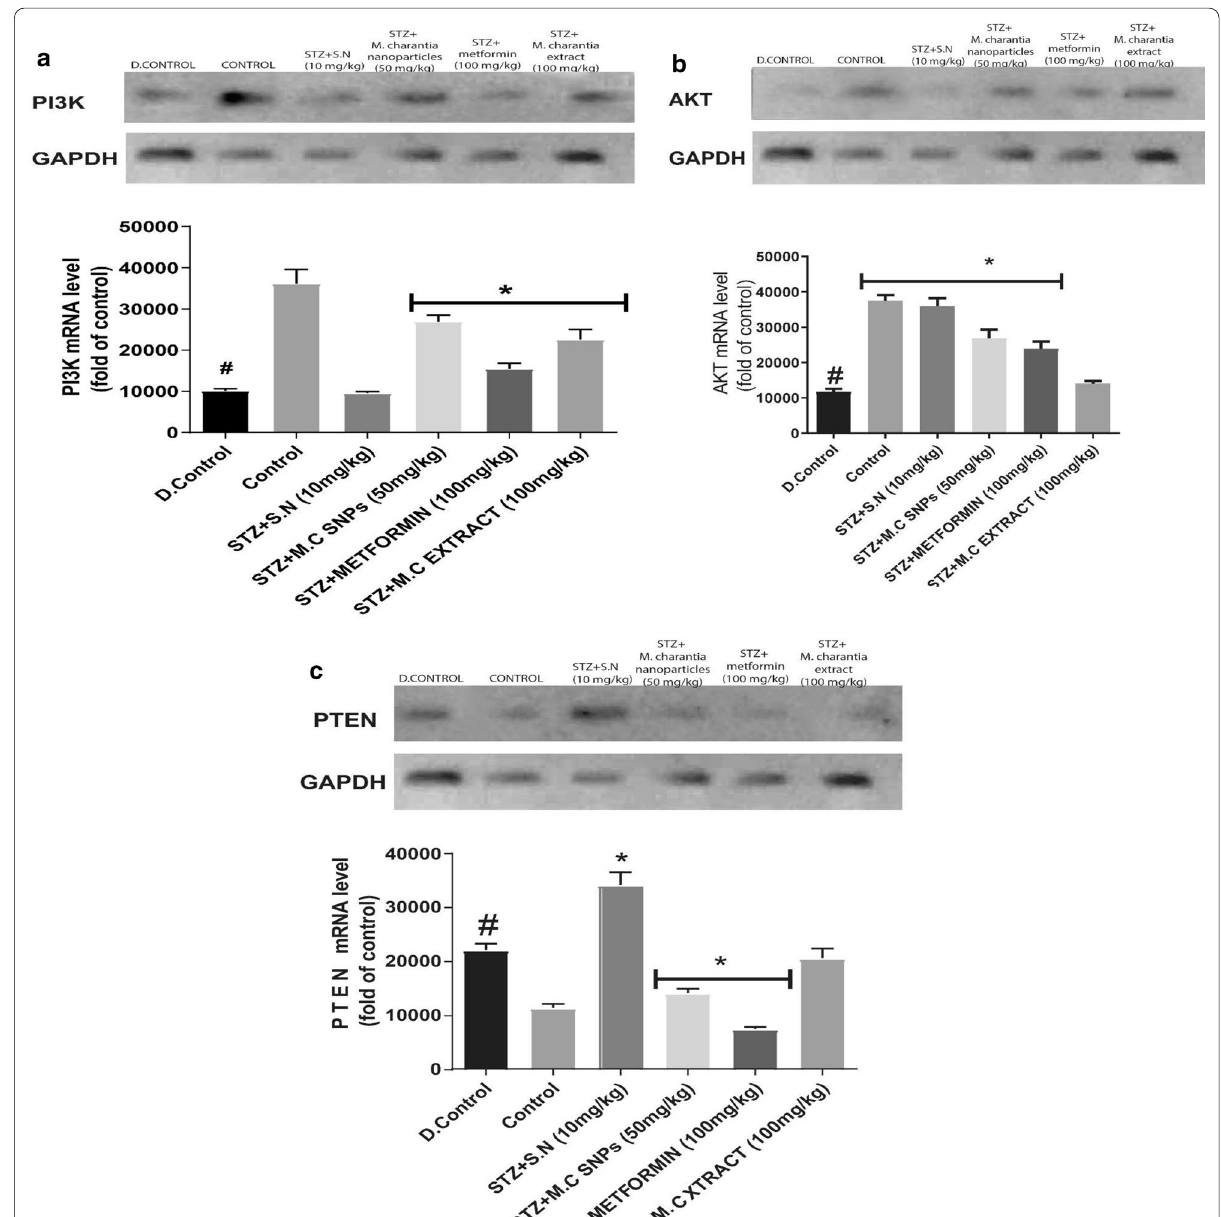
Fig. 4 a Snapshot representation of the densitometric evaluation of agarose gel electrophoresis of the reverse transcriptase polymerase chain reaction (RT-PCR) analysis of PI3K expression. *represent statistical difference to control ( p < 0.05) while # represent statistical difference to Diabetic control ( p < 0.05). b Snapshot representation of the densitometric evaluation of agarose gel electrophoresis of the reverse transcriptase polymerase chain reaction (RT-PCR) analysis of AKT expression. *represent statistical difference to control ( p < 0.05) while # represent statistical difference to diabetic control ( p < 0.05). c Snapshot representation of the densitometric evaluation of agarose gel electrophoresis of the reverse transcriptase polymerase chain reaction (RT-PCR) analysis of PTEN expression. *represent statistical difference to control ( p < 0.05) while #represent statistical difference to diabetic control ( p <